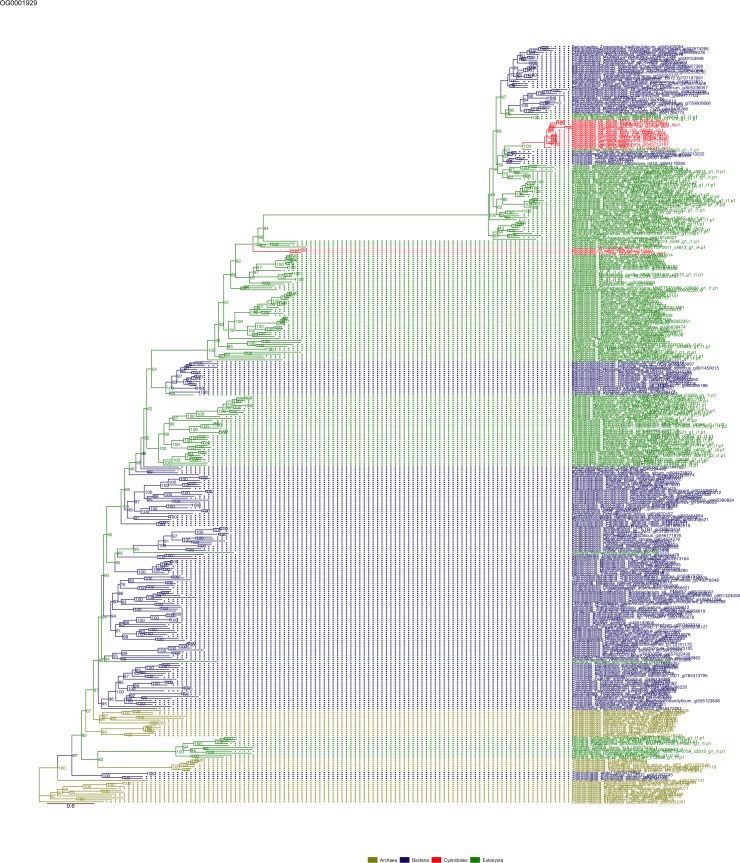
Sequence tree of orthogroup OG0001929.The tree is based on amino acid sequences. Archaea (yellow), Bacteria (blue), Cyanidiales (red), Eukaryotes including other red algae (green). Branches containing Cyanidiales sequences are highlited in red.